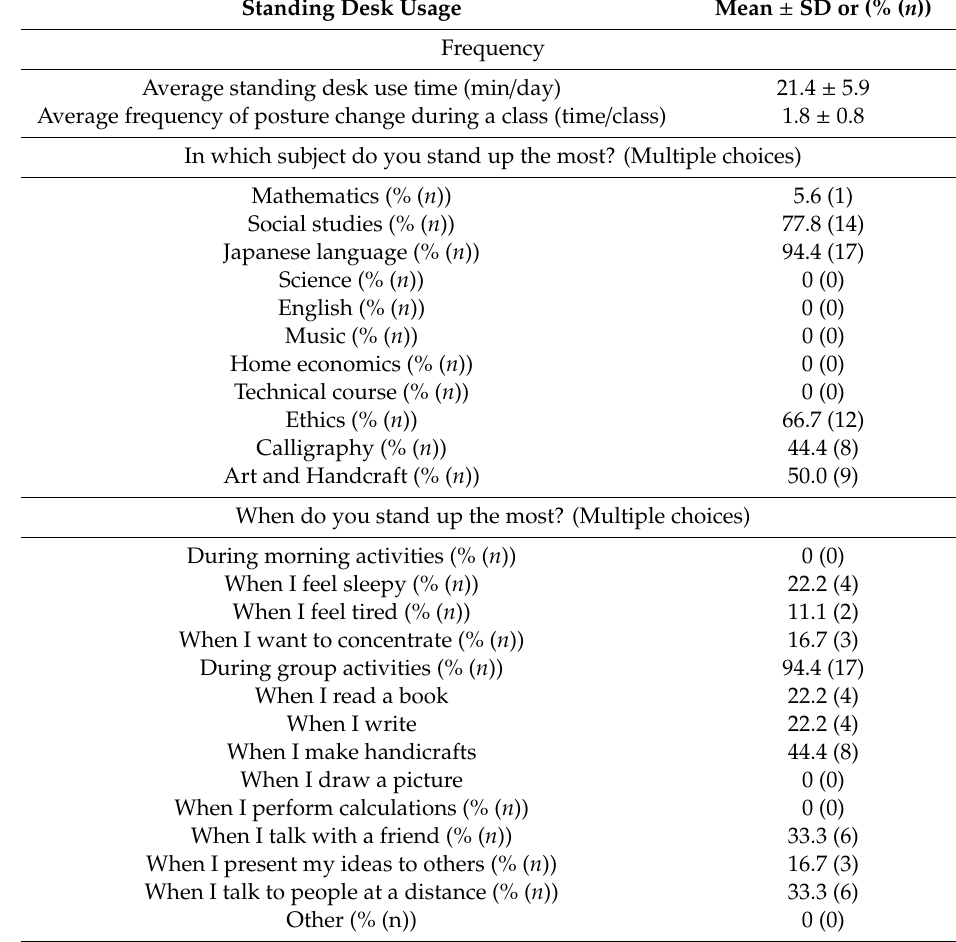
Table 2. Standing desk usage in the intervention